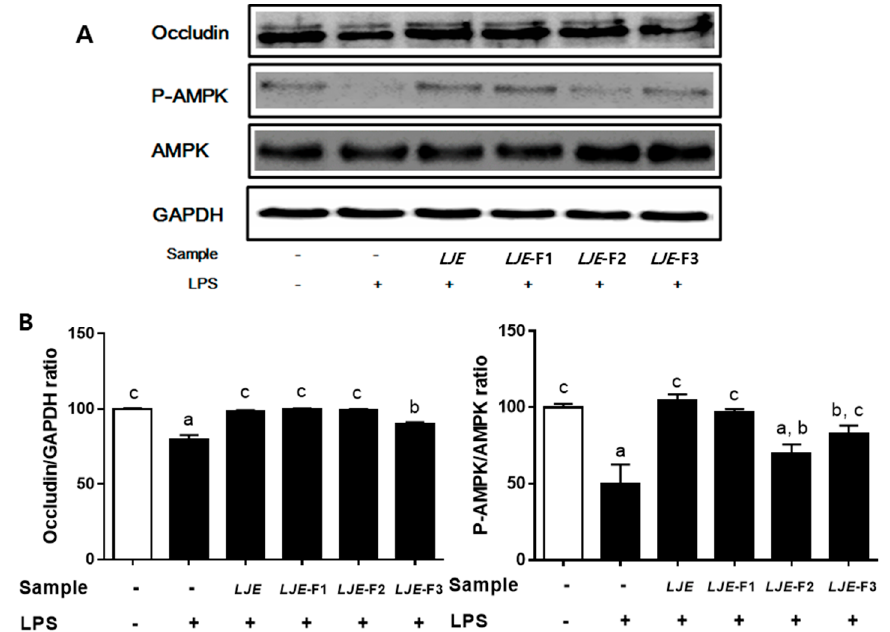
Figure 5. LJE and LJE-Fs di ff erentially promoted intestinal epithelial barrier function via upregulation of the tight junction (TJ) in Caco-2 cell monolayers. ( A ) Representative immunoblot analysis of occludin, phospho-adenosine monophosphate-activated protein kinase (P-AMPK), total AMPK, and glyceraldehyde-3-phosphate dehydrogenase (GAPDH); ( B ) intensity of occludin was normalized to GAPDH, and intensity of P-AMPK was normalized to total AMPK to account for apparent di ff erences and confirm statistical significance. Caco-2 cells were pre-incubated for 6 h with 100 µ g / mL LJE or LJE-Fs and then incubated for 24 h in the absence or presence of LPS (100 µ g / mL). Values are mean ± SEM of three independent experiments. Values that do not share the same superscript are significantly di ff erent by one-way ANOVA with Tukey’s comparisons test ( p < 0.05).